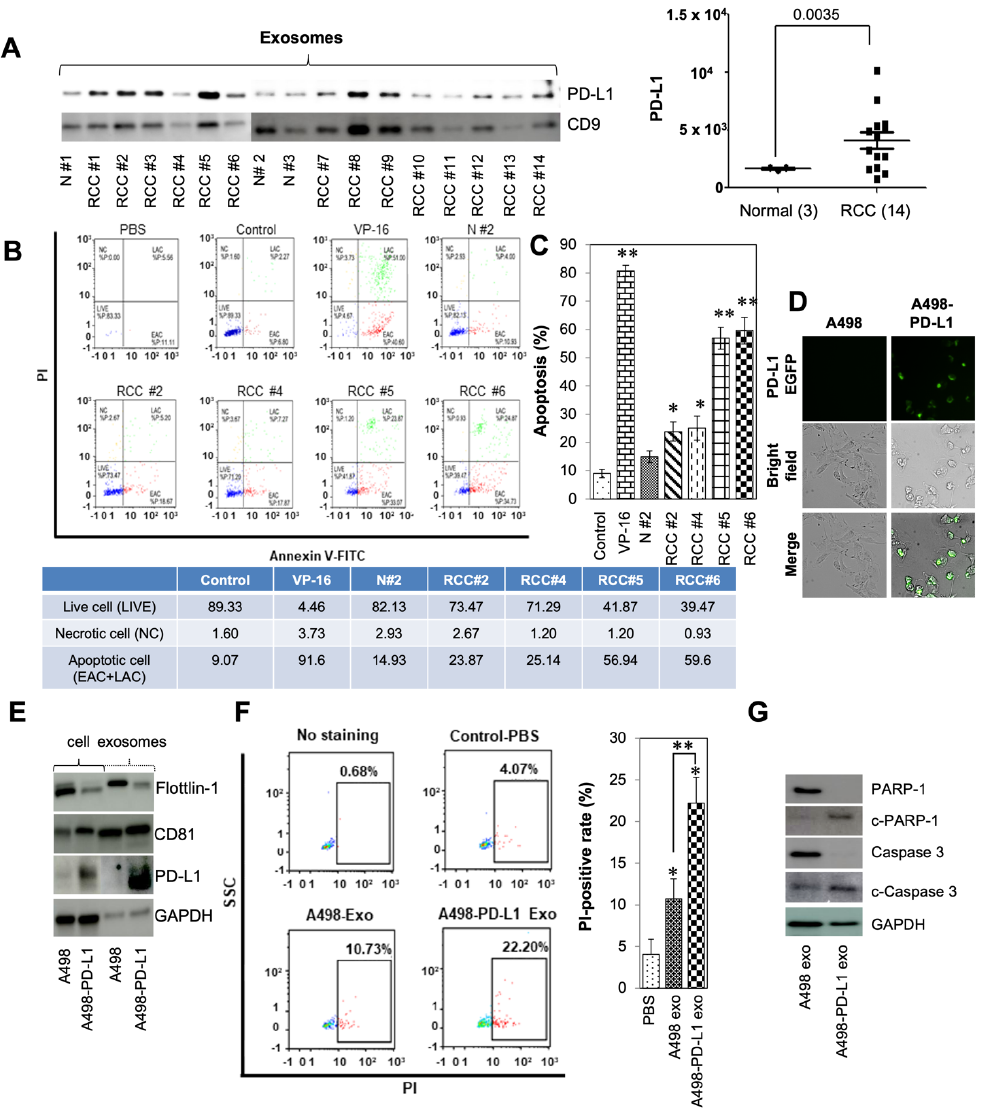
Figure 2. Effects of tumor-derived exosomes on human Jurkat T cells in patients with RCC. ( A ) Exosomes-enriched protein CD9 and protein PD-L1 were analyzed by western blotting among RCC patients and normal controls. ( B ) Apoptosis of Jurkat T cells after exposure to normal, RCC patient derived exosomes, or etoposide (VP-16) for 24 h. Apoptosis was analyzed by FACS using Annexin V-FITC/PI apoptosis kits. The induction of apoptosis was determined by flow cytometric analysis of PI-staining. Cells in the lower right quadrant (EAC; early apoptotic cells), upper right quadrant (LAC; late apoptotic cells), upper left quadrant (NC; necrotic cells), and lower left quadrant indicate live cells. ( C ) Representative results from three independent experiments. The data are presented as the mean ± SD. * p < 0.05, and ** p < 0.01 and compared with the normal group (N #2). ( D ) The A498 cells were transfected with PD-L1-EGFP vector. The cells were visualized under a fluo- rescent microscope after transfection. ( E ) Exosomes-enriched protein CD81 and protein PD-L1 were analyzed by western blotting. Full blots are presented in Supplementary Figure S8. ( F ) Apoptosis of Jurkat T cells after exposure to A498, or PD-L1 overexpressed A498 derived exosomes, for 24 h. The induction of apoptosis was determined by flow cytometric analysis of PI-staining. Cells in the square box (apoptosis) indicated PI-positive. ( G ) A498 or A498-PD-L1 exosomes induced apoptosis activation in Jurkat T cells. Jurkat T cells were exposed to 40 µ g/mL exosomes for 72 h, and the expression of caspases 3 and PAPR-1 were analyzed by western blotting. GAPDH was used as an internal control. Full blots are presented in Supplementary Figure